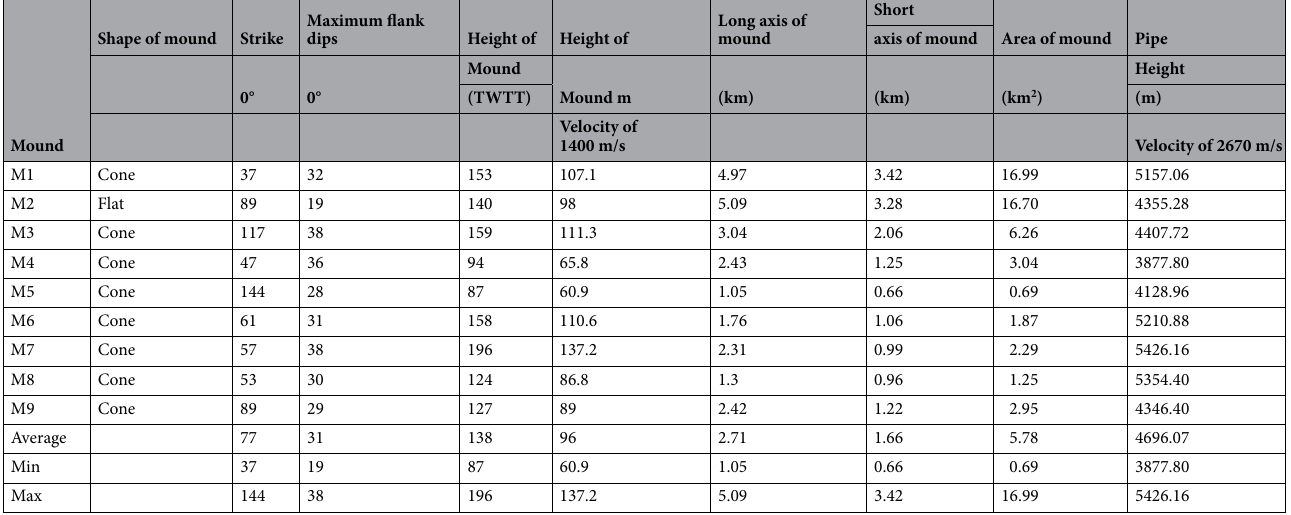
Table 1. Morphometric data for the nine interpreted